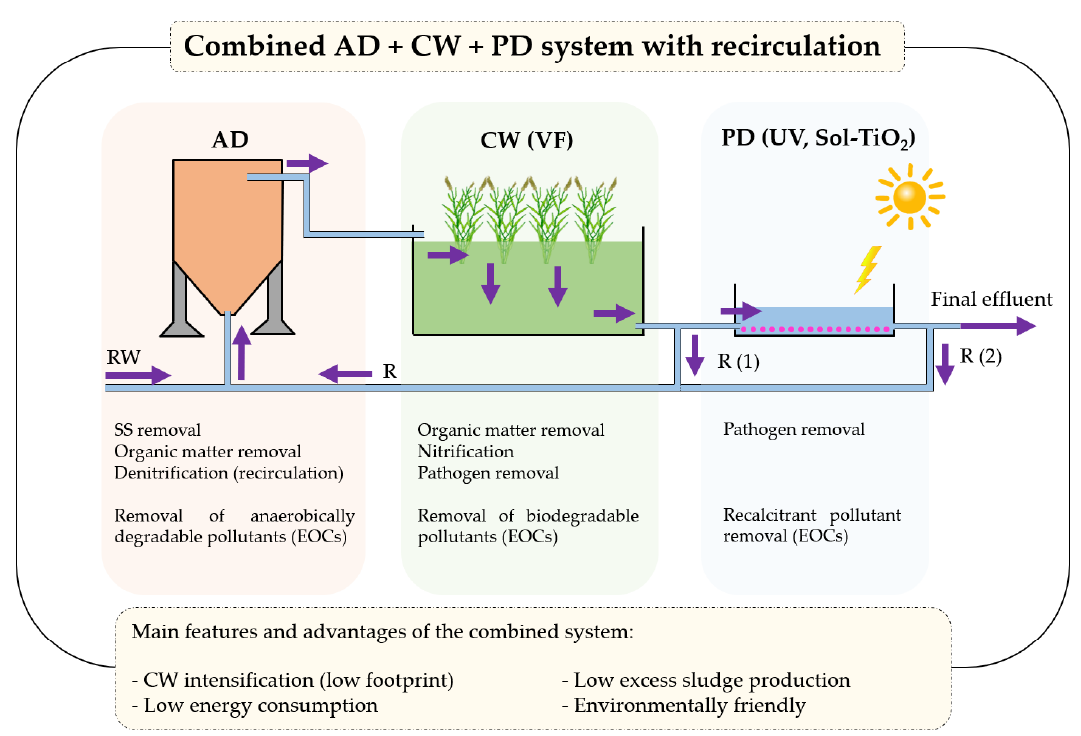
Figure 1. Combined anaerobic digester (AD), constructed wetland (CW), and photodegradation (PD) system with recirculation: The three technologies are complementary, requiring recirculation (two optional positions in the figure) to integrate treatment processes and achieve a true hybrid system with additional advantages to those of the multiple barrier concept.